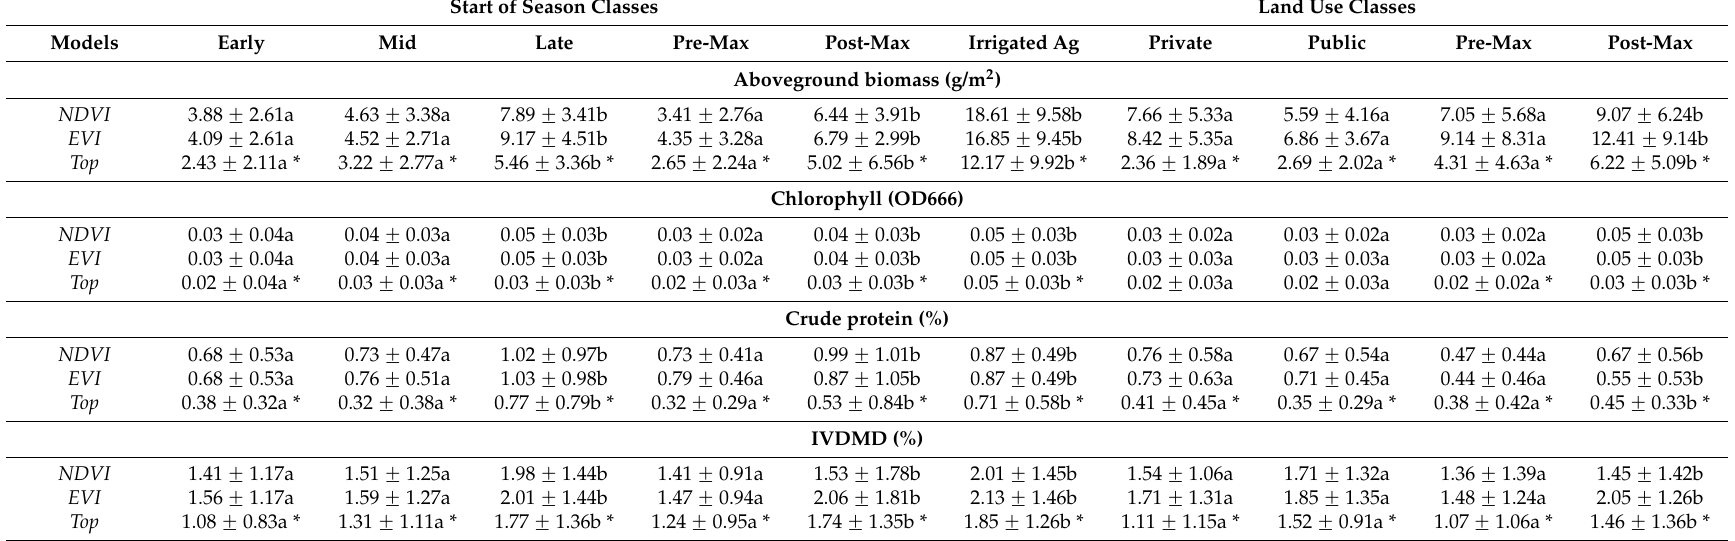
Table 2. The average root mean squared errors (AVG ˘ SE) from the linear NDVI, linear EVI, and top models of biomass, chlorophyll, crude protein, and IVDMD in the different start of season classes, land use classes, and before/after the peak in biomass in the Upper Yellowstone River Basin. Letters represent differences ( p < 0.001) in model estimates between classes and * represents differences within